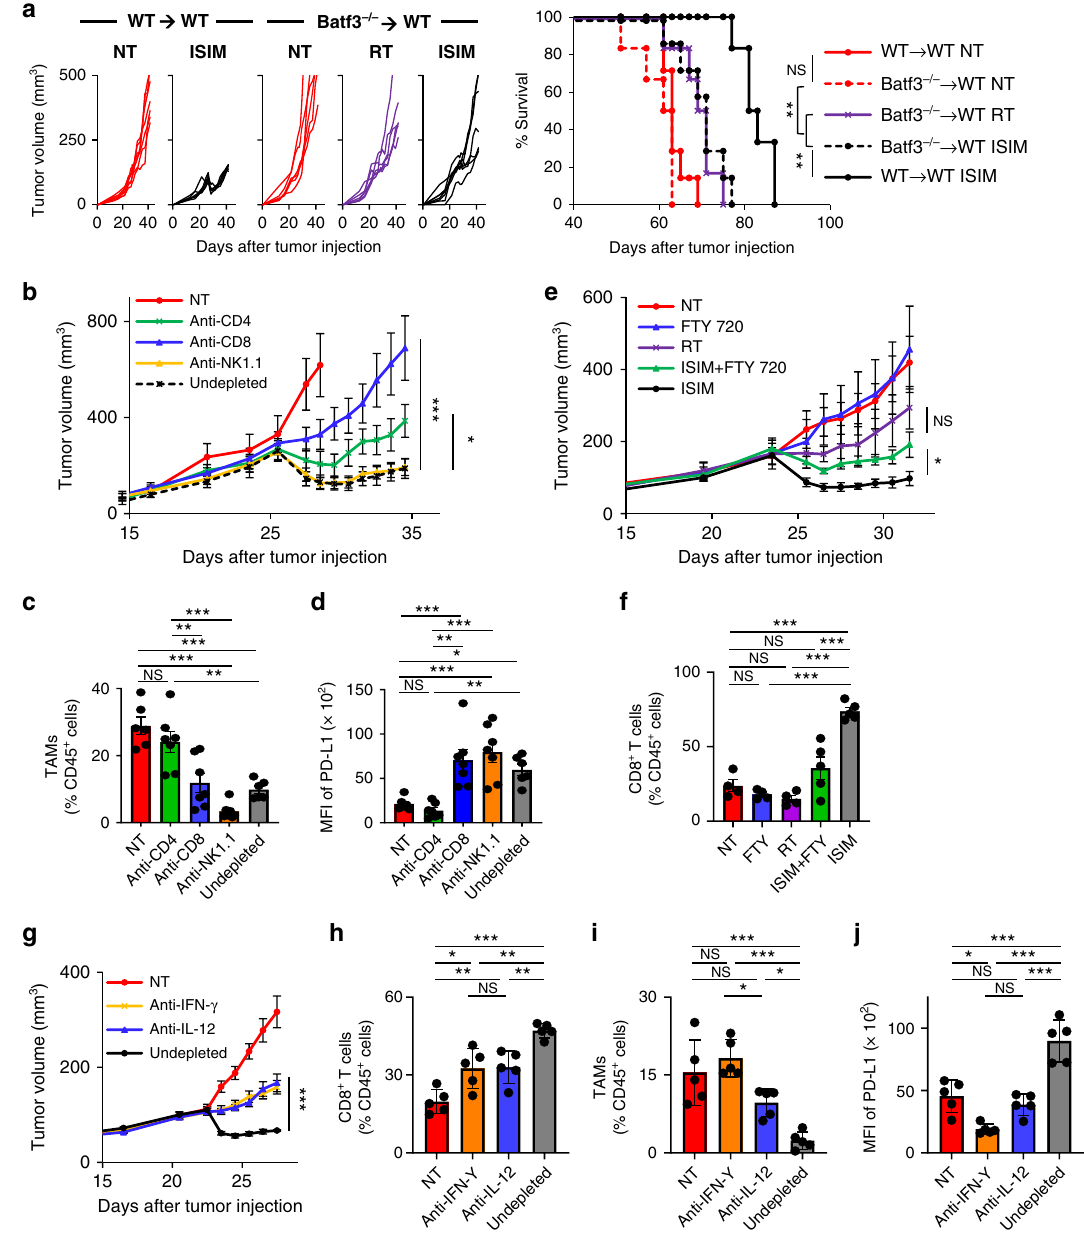
Fig. 9 In situ immunomodulation (ISIM) elicits IFN- γ and IL-12-dependent de novo adaptive T cell immunity mediated by Batf3-dependent DCs. a Tumor growth curves (individual) and survival curves in AT-3 tumor-bearing mice reconstituted with wild-type C57BL/6 mice bone marrow (WT → WT) or Batf3 − / − mice (Batf3 − / − → WT) in different treatment groups as indicated. n = 6 mice (ISIM of WT → WT, NT of Batf3 − / − → WT, RT of Batf3 − / − → WT) and 7 mice (NT of WT → WT, ISIM of Batf3 − / − → WT). NS not signi fi cant, ** p < 0.01 by a log-rank test. b – j Tumor growth curves (mean) ( b , e , g ), frequency of tumor-associated macrophages (TAMs: Ly6c − class II + CD24 − F4/80 + ) among CD45 + cells ( c , i ), frequency of CD8 + TILs among CD45 + cells ( f , h ), and median fl uorescence intensity (MFI) of PD-L1 in TAMs ( d , j ) in AT-3 tumor-bearing mice in different treatment groups as indicated. n = 6 mice (NT, undepleted) and 7 mice (Anti-CD4, Anti-CD8, and Anti-NK1.1) ( b – d ), n = 4 mice (NT, FTY720, RT) and n = 5 mice (ISIM + FTY720, ISIM) ( e , f ), and n = 5 mice in all groups ( g – j ). Tumors were harvested 7 or 8 days after TLR3/CD40 stimulation ( b – j ). NS not signi fi cant, * p <0.05, ** p <0.01, *** p <0.001. Two- tailed t -test ( b , e , g ) or one-way ANOVA with Tukey ’ s multiple comparisons ( c , d , f , h – j ). Mean±SEM. Source data are provided as a Source Data fi resulting in durable complete responses in all treated mice after (Supplementary Fig. 21a), and generation of systemic immu- the fourth cycle (Fig. 10c). These surviving mice rejected the nological memory against B16 melanoma (Supplementary same AT-3 tumors rechallenged in the contralateral mammary Fig. 21b). Taken together, these fi ndings suggest that in situ fat pad, but not unrelated B16 tumors inoculated on the back, induction and activation of cDC1s could reshape intratumoral suggesting the development of tumor-speci fi c systemic immu- T cell type, density and repertoires, convert poorly T cell- nological memory (Fig. 10d). In line with this, we also observed in fi ltrated tumors, and overcome primary and acquired resis- curative potential of serial ISIM and anti-PD-L1 therapy tance to anti-PD-L1 therapy.